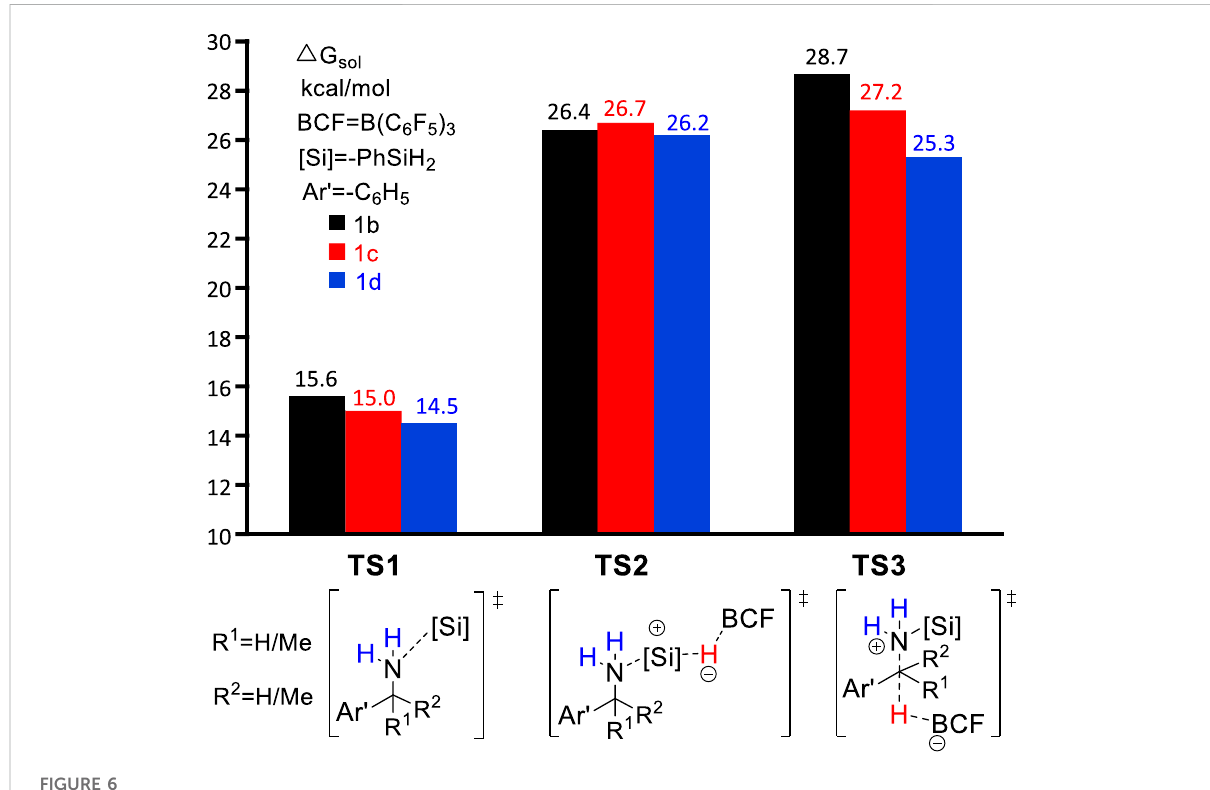
FIGURE 6 Gibbs energy of transition states TS1, TS2, and TS3 for different